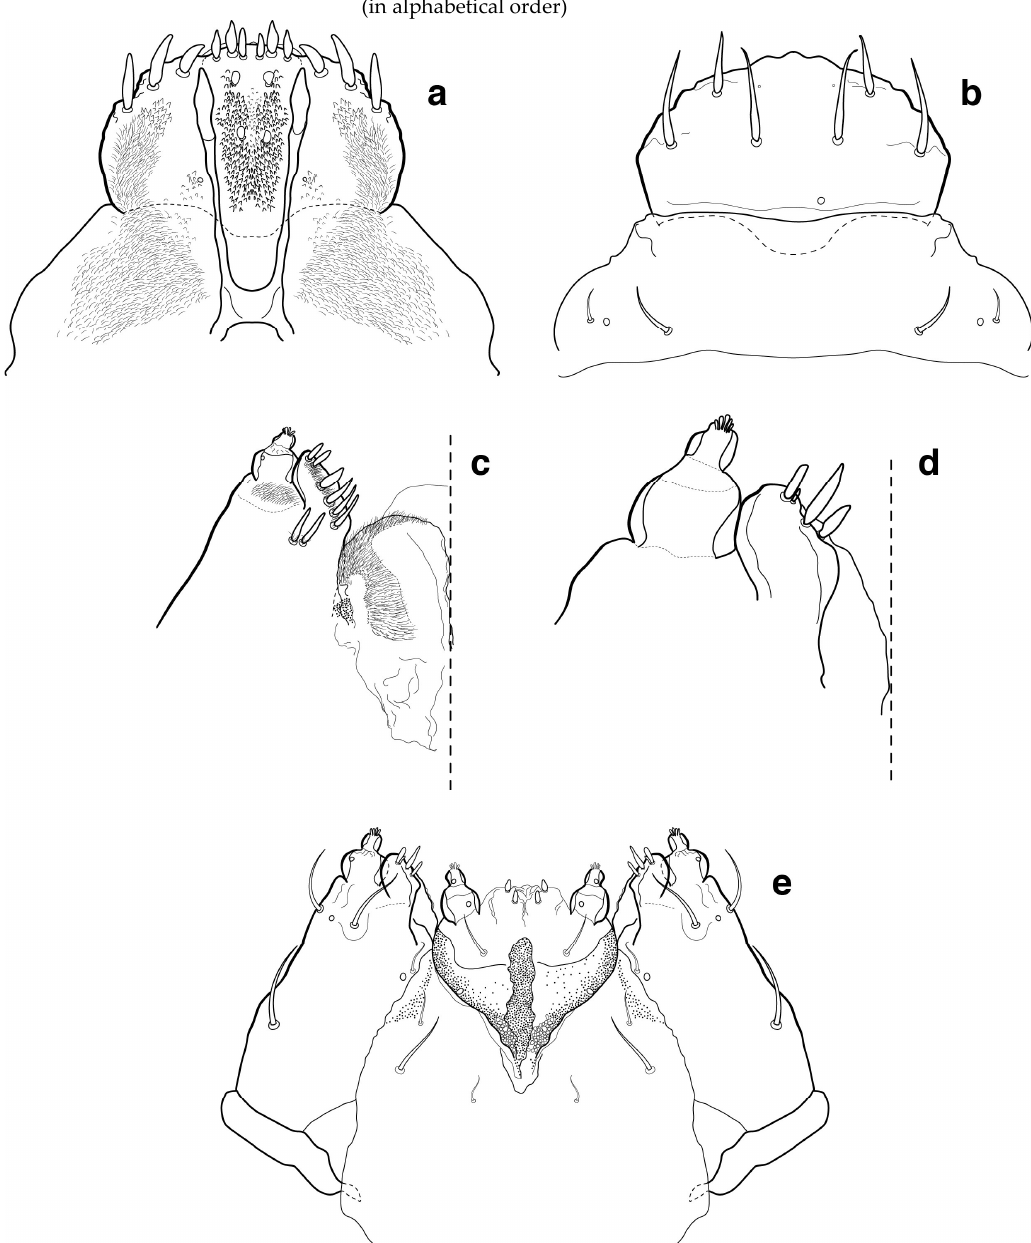
Figure 56. Cactophagus validus mouthparts: ( a ) epipharynx; ( b ) clypeus and labrum; ( c ) detail of 1051 hypopharynx, mala, and maxillary palp, dorsal view; ( d ) detail of mala and maxillary palp, ventral 1052 view; and ( e ) labio-maxillary complex, ventral view. 1053